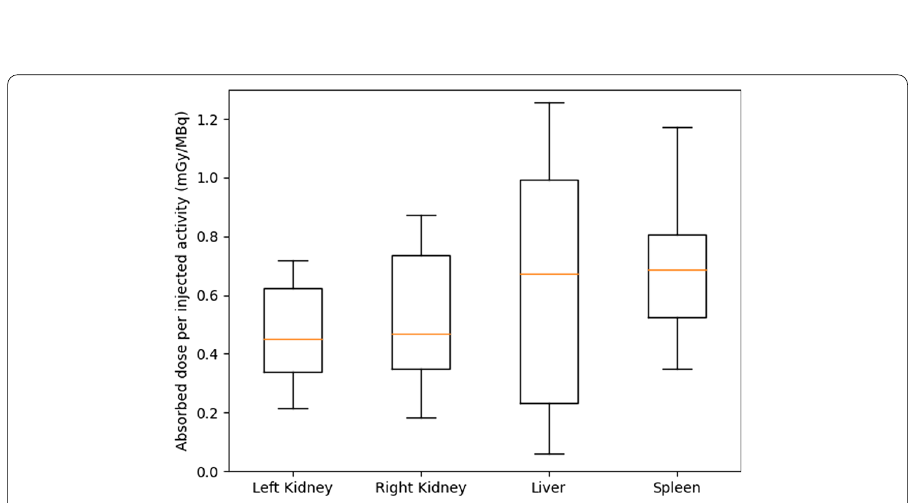
Fig. 3 Boxplots representing doses per injected activity (mGy/MBq) averaged on all cycles available for each patient of the patient cohort and each organ (left kidney, right kidney, liver and